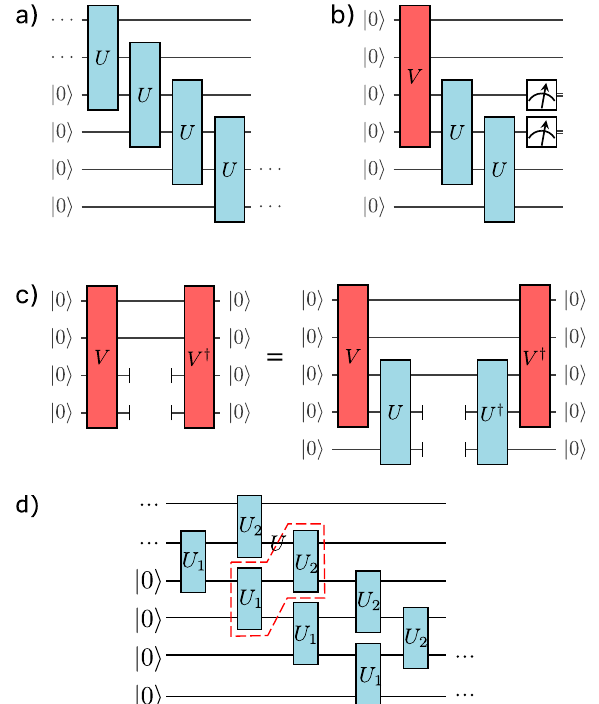
Fig. 2 Quantum circuits for translationally invariant states and their local measurement. a An in fi nite depth and width quantum circuit representing a translationally invariant state. U ∈ SU ( dD ) with d the local Hilbert space dimension and D = 2 N the bond order. d = 2 for spin 1/2 and is used exclusively throughout this paper. In these illustrations D = 4. The circuit acts upon a reference state 000 ¼ j i at the left of the fi gure with unitary operators applied sequentially reading left to right. b Local measurements on this translationally invariant state can be reproduced exactly by the fi nite circuit shown. The reduced form takes advantage of the unitarity of U , due to which sites to the left of the observable do not contribute. The environment unitary V ≡ V ( U ) ∈ SU ( D 2 ) summarises the effect of sites to the right of the observable and describes an effective state over